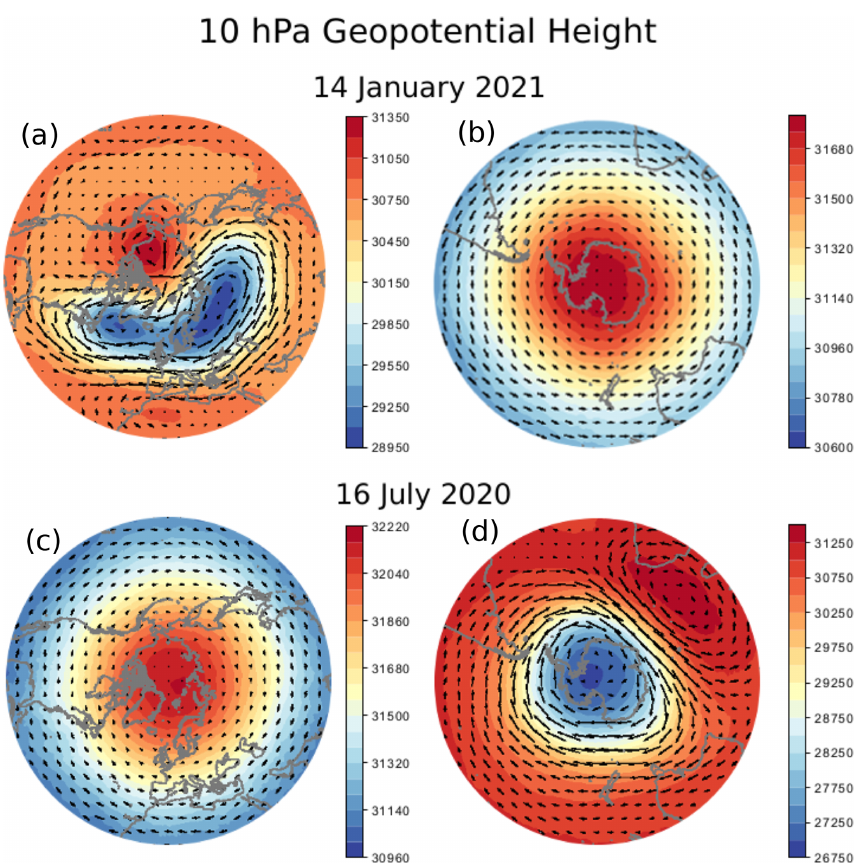
Figure 3. Geopotential height (m) and vectors of horizontal wind (ms − 1 ) at 10hPa for (a) 14 January 2021 and (c) 16 July 2020 for the NH and (b) 14 January 2021 and (d) 16 July 2020 for the SH. From UK Met Office daily operational analysis for